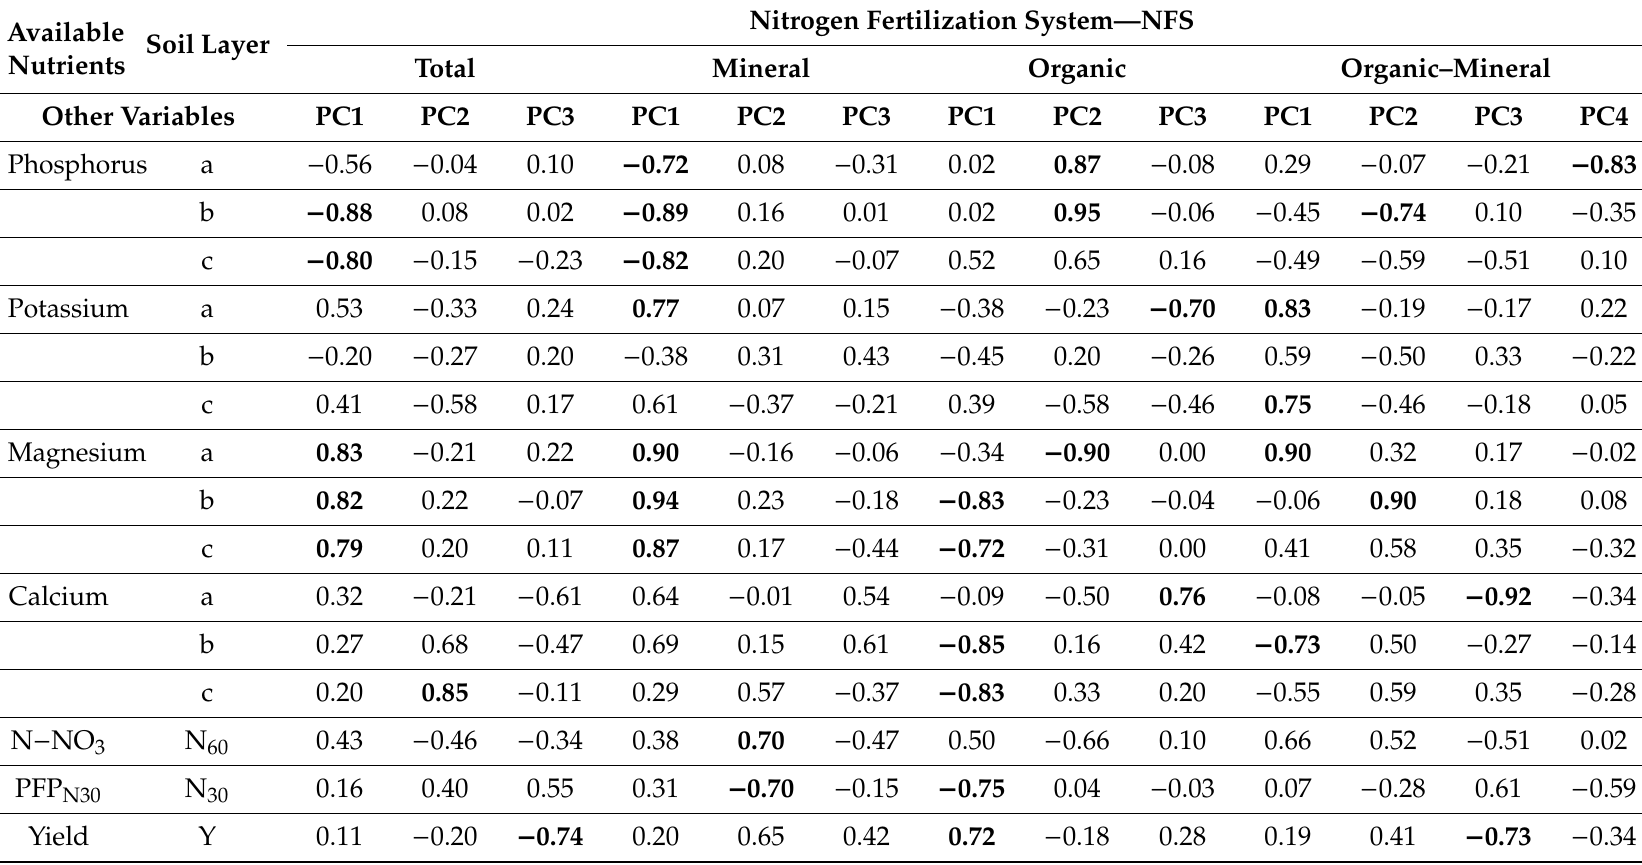
Table A3. Principal component analysis of the content of available nutrients and nitrate nitrogen, and yield at the onset of flowering (BBCH